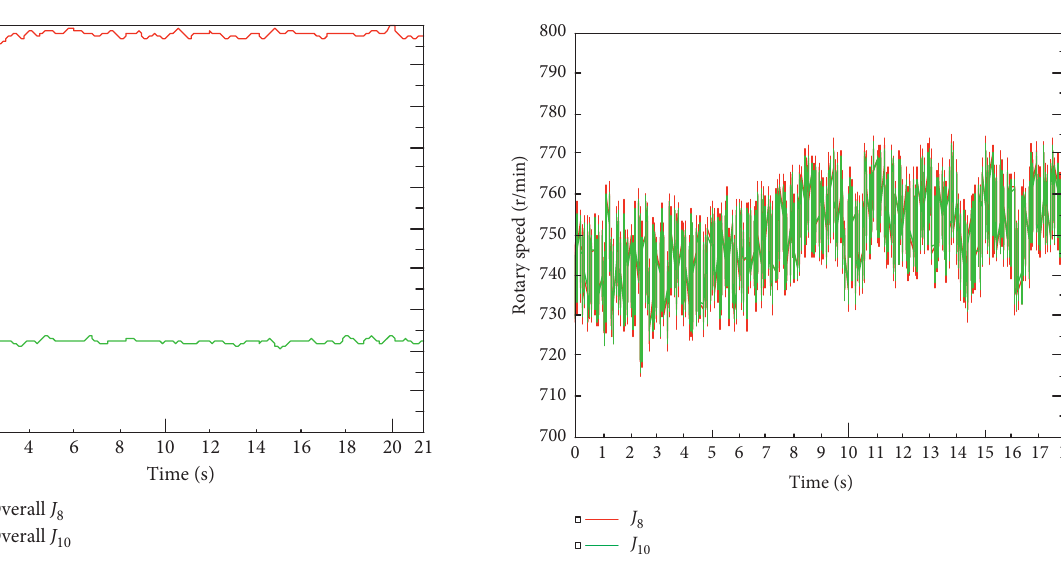
Figure 29: The rotary speed curves of the primary flywheel and the input shaft of the gearbox matching the DMF with the bifilar CPVA under the idling condition.